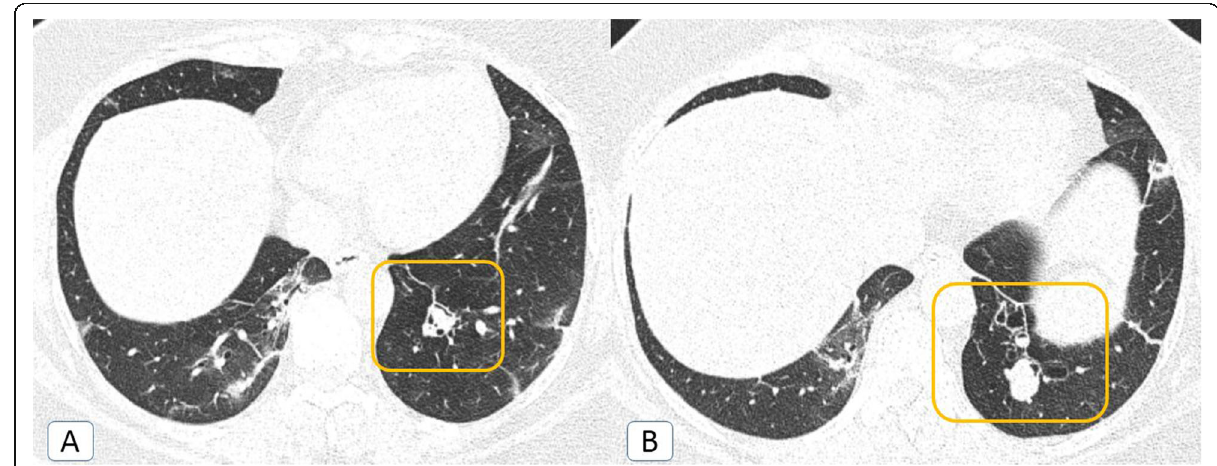
Fig. 10 COVID-19 infection complicated by secondary fungal infection: a 49-year-old male COVID-19 patient without a history of previous chest disease. A Axial chest CT (lung window) showing bilateral basal sub-pleural ground glass patches and fibro-atelectatic bands of COVID-19 infection together with left basal small cavitary lung lesion with eccentric rounded soft tissue density (fungus ball or mycetoma) with eccentric air (air-crescent sign). B Axial chest CT (lung window) additionally left basal cystic bronchiectatic changes with mucous plugging and air-fluid